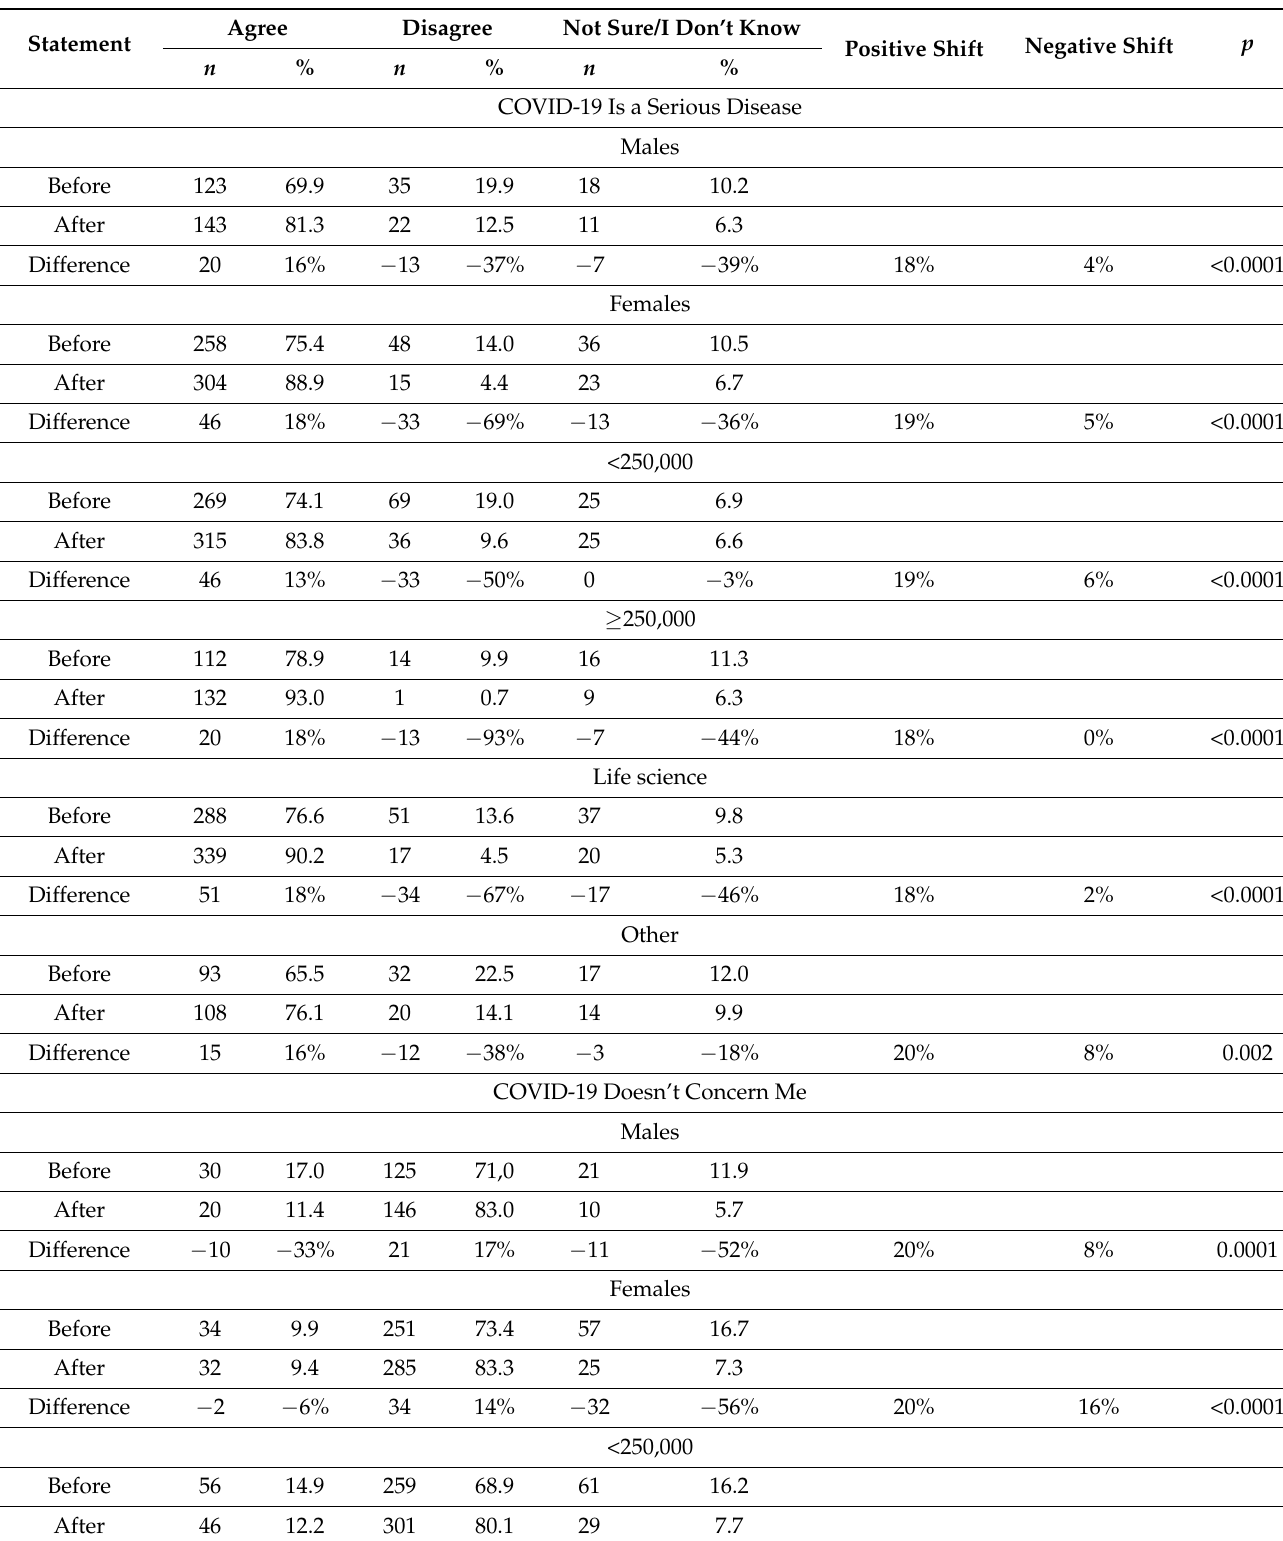
Table 3. Attitudes toward SARS-CoV-2 andCOVID-19 pre- and post-intervention by gender, school location, and curriculum track, final year high school students, Poland, 2020 ( n =